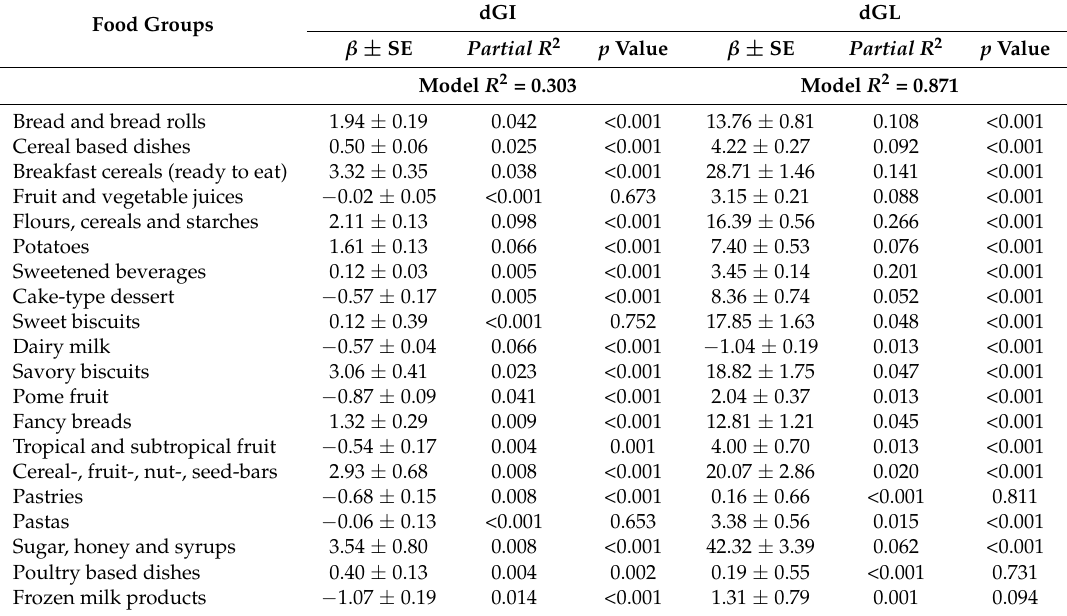
Table A6. The contribution of the top 20 GL food groups to inter-individual variations in dietary glycaemic index (dGI) and glycaemic load (dGL) in 2012NS ( n = 2374, all subjects